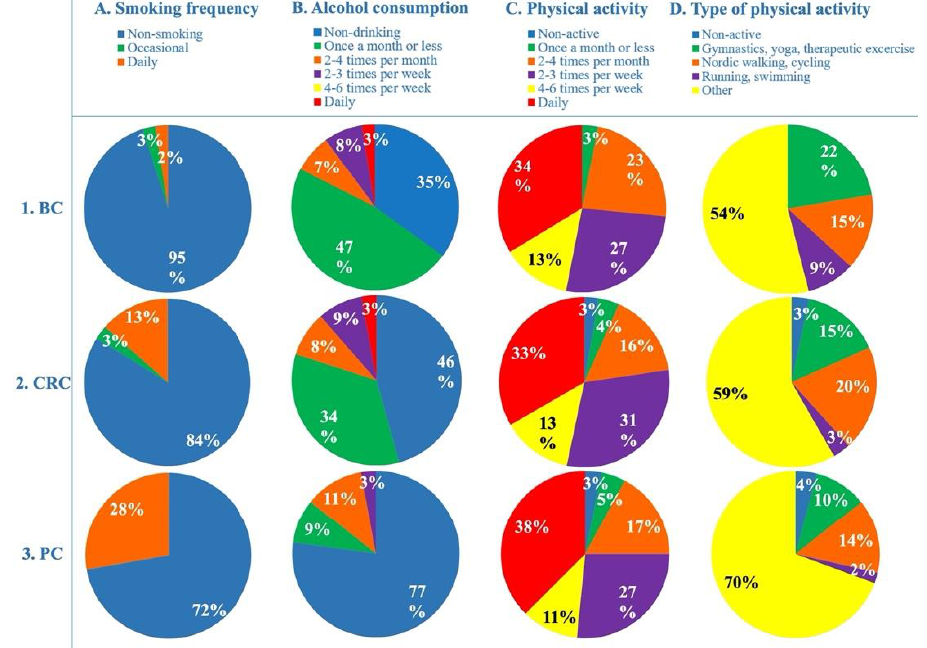
Figure 2. Frequency of smoking, alcohol consumption and physical activity/type in breast. 1. ( A – D ), colorectal 2. ( A – D ) and pancreatic cancer patients 3. ( A – D ). BC — breast cancer patients, CRC — colorectal cancer patients, and PC — pancreatic cancer patients.